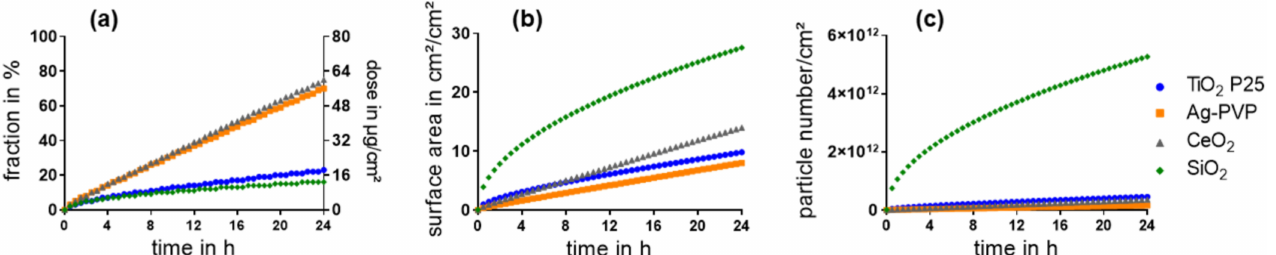
Figure 1. Sedimentation of ENM within 24 h was estimated with the ISDD model based on an initially administered dose of 80 µ g/cm 2 . The sedimented fraction in % ( a left y-axis ), sedimented mass in µ g/cm 2 ( a right y-axis ), surface area of the sedimented particles ( b ), and sedimented particle number per cm 2 ( c ) were